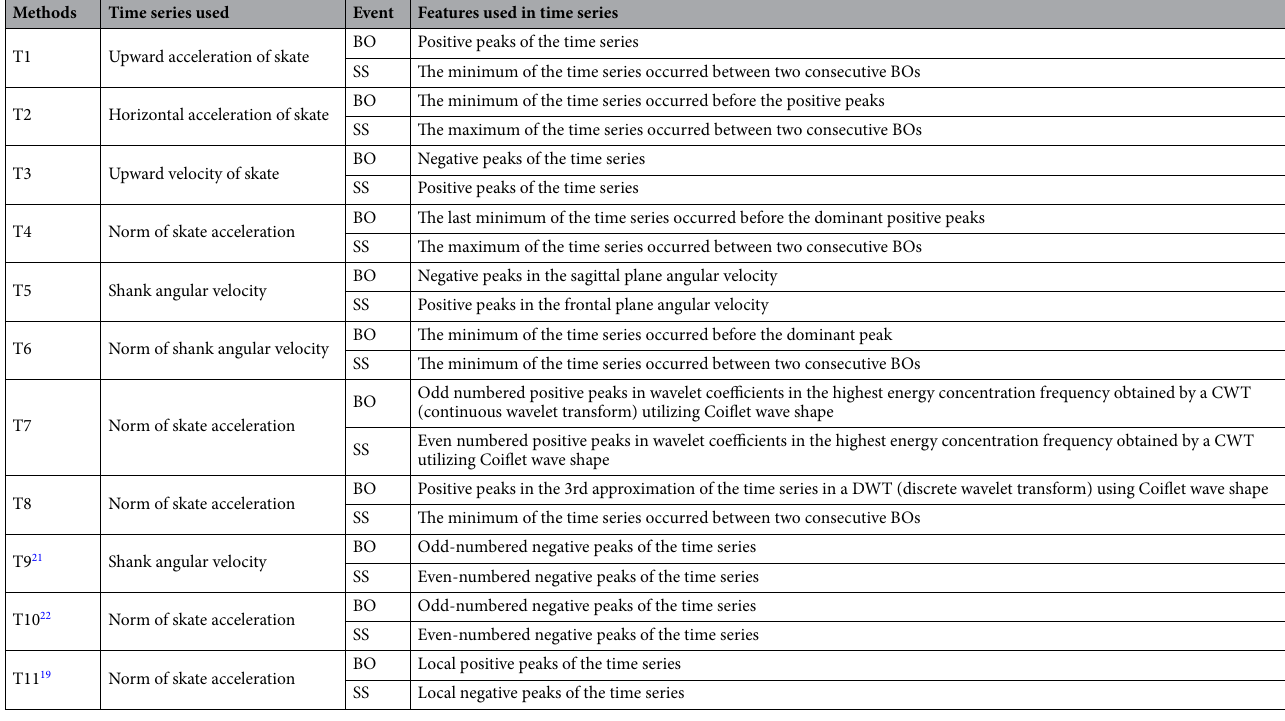
Table 1. Description of the methods originally proposed (T1–T8) and adopted from the literature and modified (T9–T11) for detection of Skate Strike (SS) and Blade off (BO) instants during forward skating using the readouts of IMUs placed on the shanks or skates. Similar to the original gait analysis studies (T9–T11), it was assumed that the participant starts skating from a stationary position, and thus, starts by a BO (toe-off in original studies). Therefore, the odd negative peaks indicate BO (toe-offs in original studies), and the even peaks indicate SS (heel-strike in original